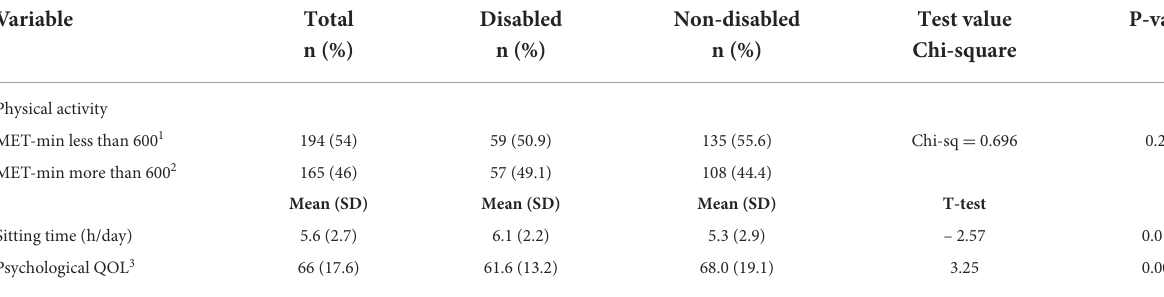
TABLE 2 Comparison of physical activity status, sitting time and psychological QOL among disabled and non-disabled.